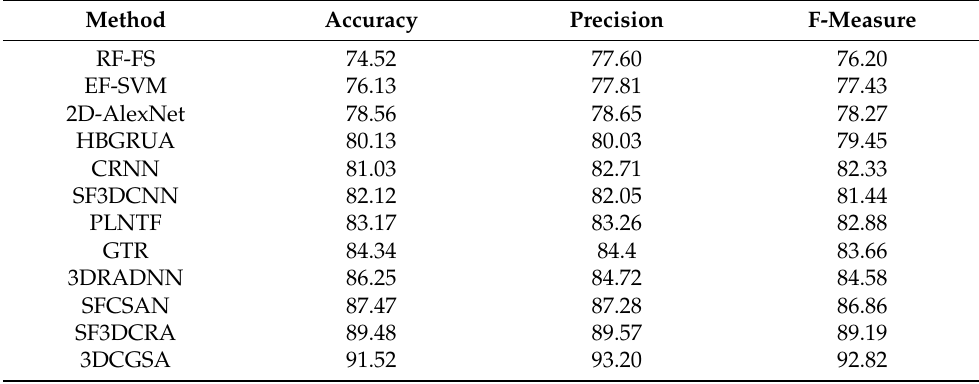
Table 3. Stress recognition results using the two-level EDESC